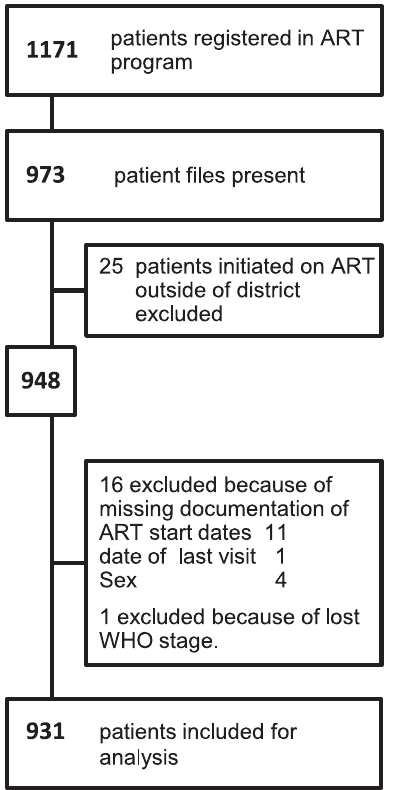
Figure 1. Patients included for hazard ratio analysis.